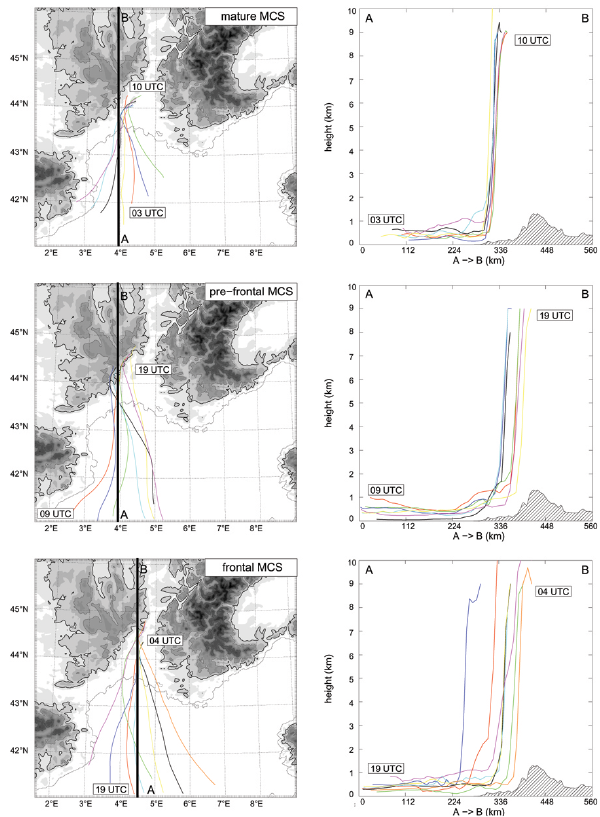
Fig. 12. Backward trajectories of some air parcels taken of the 21 October 2008 precipitating systems simulated by HRA2.5 in three different phases of the event – mature convection well ahead of the front (top), pre-frontal convection (middle) and convection embedded in a frontal disturbance (bottom). The backward trajectories are projected both on an horizontal plane (left panels) and on a vertical cross-section (right panels). The vertical cross- section follows the line AB displayed on the left planels. The orography is superimposed in grey scale as in Fig. 2 for the left panels and as a hatched area for the right